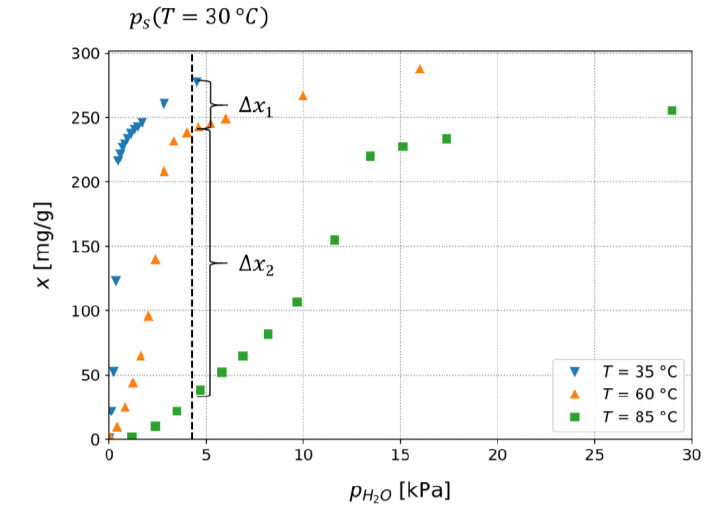
Figure 3. Connection of isobaric desorption of water from TAPSO-34 and adsorption isotherms of pure TAPSO-34 powder (data taken from Kohler et al. [14]). The amount of desorbed water ∆ x depends on the loading difference of the different isotherms at the same water vapor pressure.